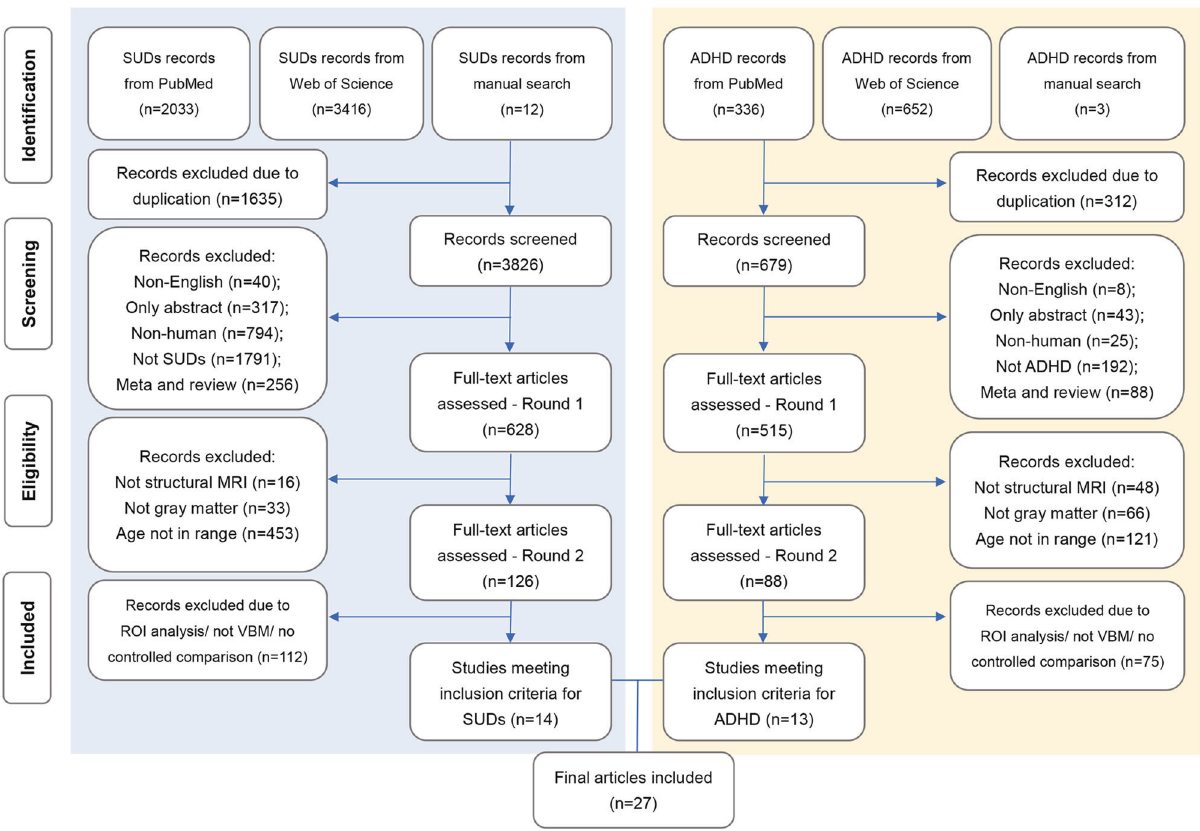
Fig. 1 Flowcharts of the literature search and selection criteria for articles on attention de fi cit/hyperactivity disorder (ADHD) and substance use disorders (SUDs) in the meta-analysis. MRI Magnetic resonance imaging, ROI Region of interest, VBM Voxel-based